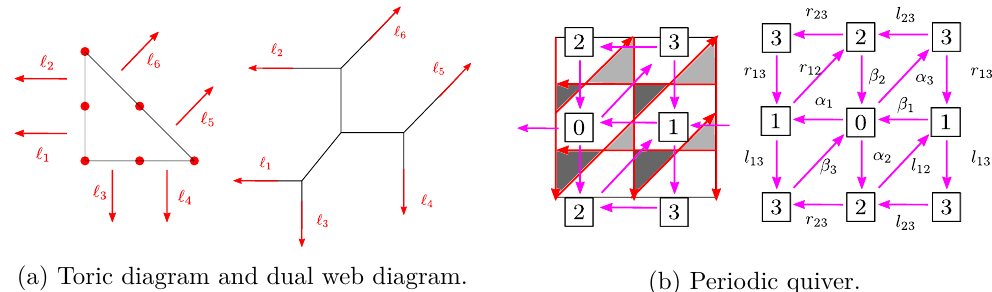
Figure 9. Toric diagram, dual web diagram, and periodic quiver of C 3 / ( Z 2 × Z 2 ) . The six lattice points of the toric diagram are denoted as (0 , 0) , (1 , 0) , (2 , 0) , (0 , 1) , (0 , 2) , and (1 , 1)